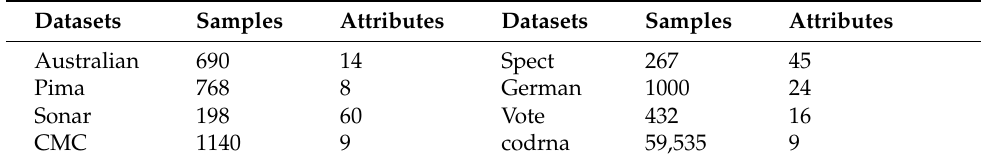
Table 1. Characteristics of UCI datasets.